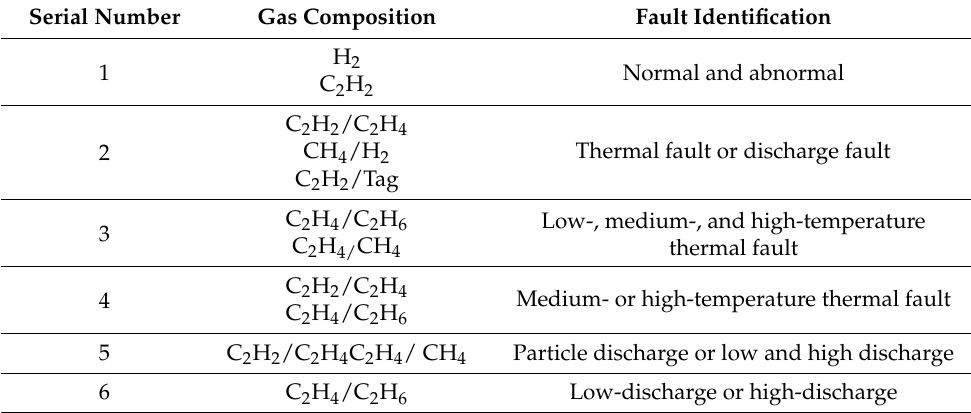
Table 1. Fusion parameter model of